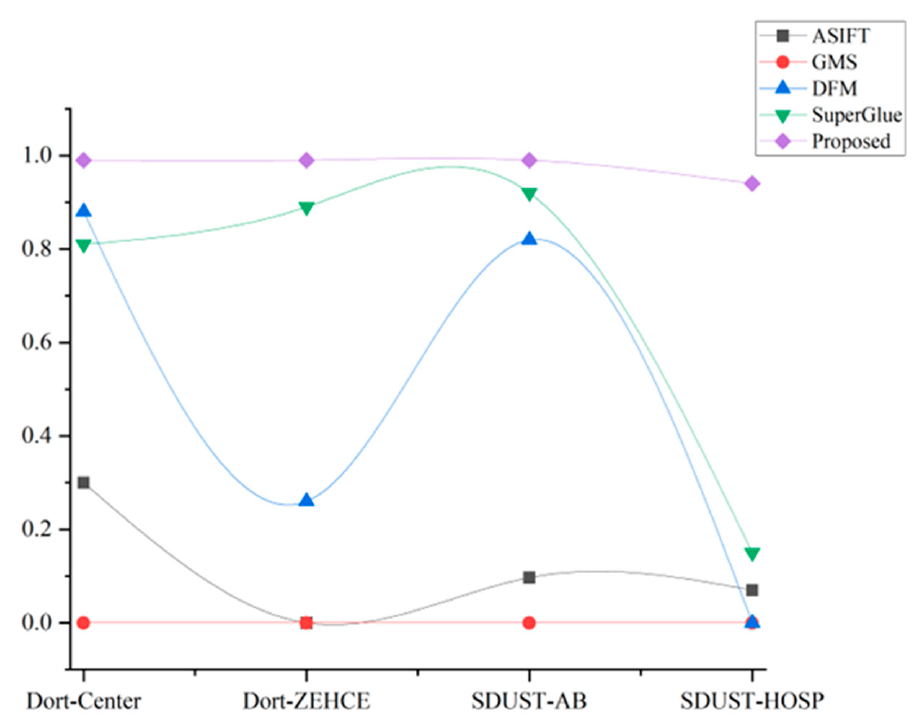
Figure 20. Mean inliers of each dataset.